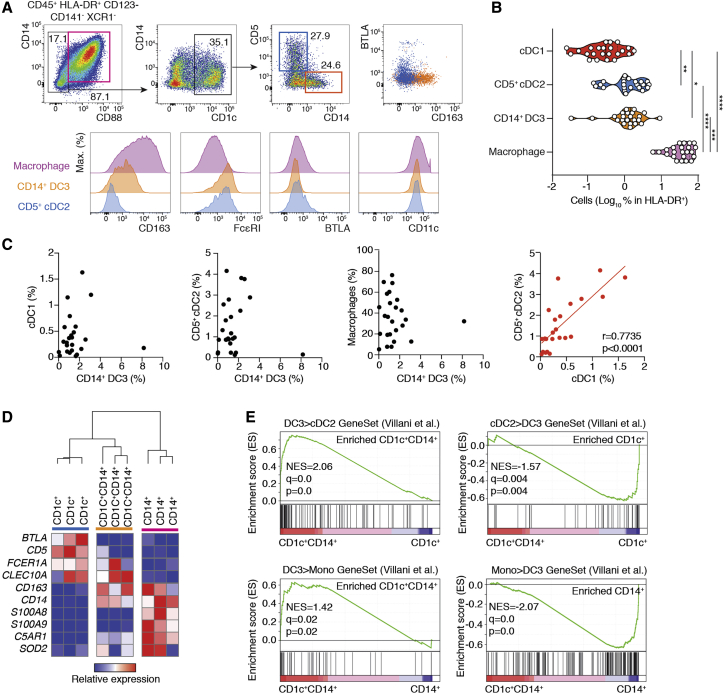
DC3s Infiltrate Human Breast Tumors(A) Representative gating strategy used to define macrophages, CD5+ cDC2s, and CD14+ DC3s and histograms showing the expression of CD163, FcεRI, BTLA, and CD11c in human breast cancer primary tumors.(B) Violin plot quantifying cDC1, CD5+cDC2, CD14+ DC3, and CD14+CD88+ macrophage subsets identified in (A) in human breast cancer primary tumors (n = 25; ∗p < 0.05, ∗∗p < 0.01, ∗∗∗p < 0.001, ∗∗∗∗p < 0.0001, one-way ANOVA test).(C) Pearson correlations of the frequencies of macrophages, cDC1s, CD5+cDC2s, and CD14+ DC3s within HLA-DR+ cells in human breast cancer primary tumors (red, significantly correlated p < 0.05; black, not correlated).(D) HC showing the relative expression of markers used for subset identification in Figure 1 in CD1c+, CD1c+CD14+, and CD14+ cells from invaded lymph nodes draining human breast cancer primary tumors.(E) GSEA of pairwise comparisons of CD1c+CD14+ cells with CD1c+ or CD14+ from invaded lymph nodes draining human breast cancer primary tumors. Gene signatures of blood DC3s compared with cDC2s (DC3 > cDC2) or CD14+ monocytes (DC3 > Mono) and, vice versa, of blood cDC2s (cDC2 > DC3) or CD14+ monocytes (Mono > DC3) compared with DC3s were used (Villani et al., 2017).See also Figure S2 and Table S2.